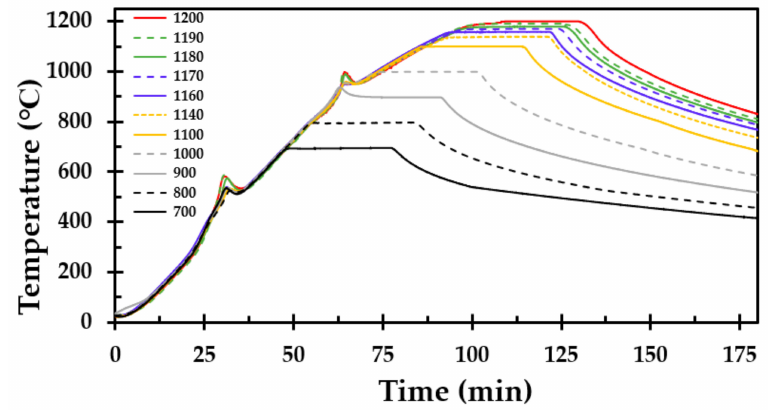
Figure 4. Measured temperature as a function of time, measured at the center of the test specimen, for each holding temperature presented in Table